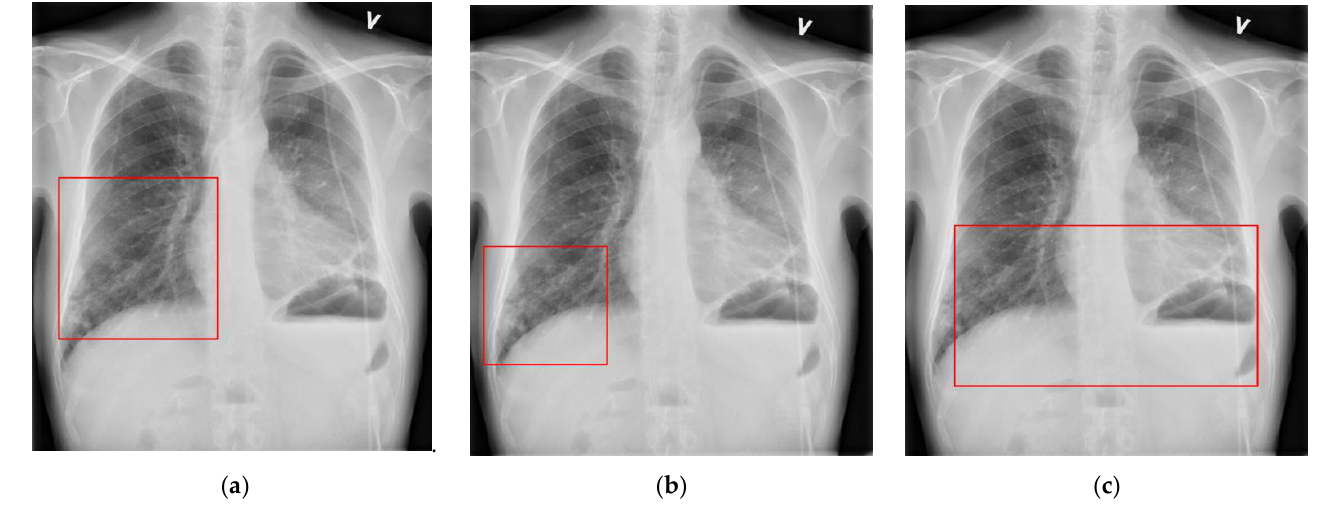
Figure 4. Examples of annotation bounding boxes labeled as ( a ) ‘Decreased translucency’ by a novice radiologist, ( b ) ‘Infiltrate’ by an intermediate radiologist, and ( c ) ‘Infection’ by an experienced radiologist on the same CXR case. Other findings and bounding boxes have also been used in this case but are not represented in this